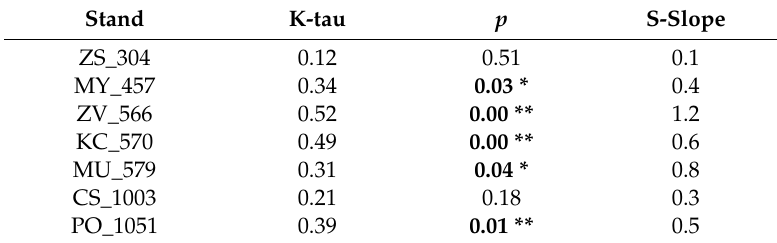
Table 9. M-K trend test of the onset of leaf colouring (LCO): significant trends with p ≤ 0.1 (**) and p ≤ 0.5 (*) are highlighted in